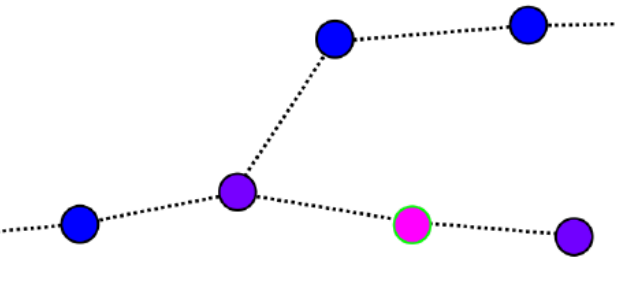
Figure 2. Graph of place cells associated with navigation in a physical space (pink node: place cells with firing activity, blue nodes: inactive place cells. Active place cell is designated with a green